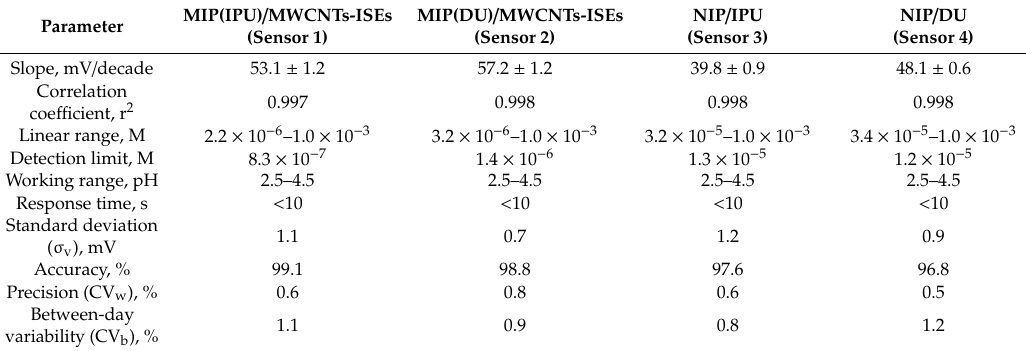
Figure 5. Calibration plots for all solid-contact ISEs in the Britton–Robinson (BR) buffer solution (pH = 3.0). Table 1. Potentiometric response characteristics of phenylureas